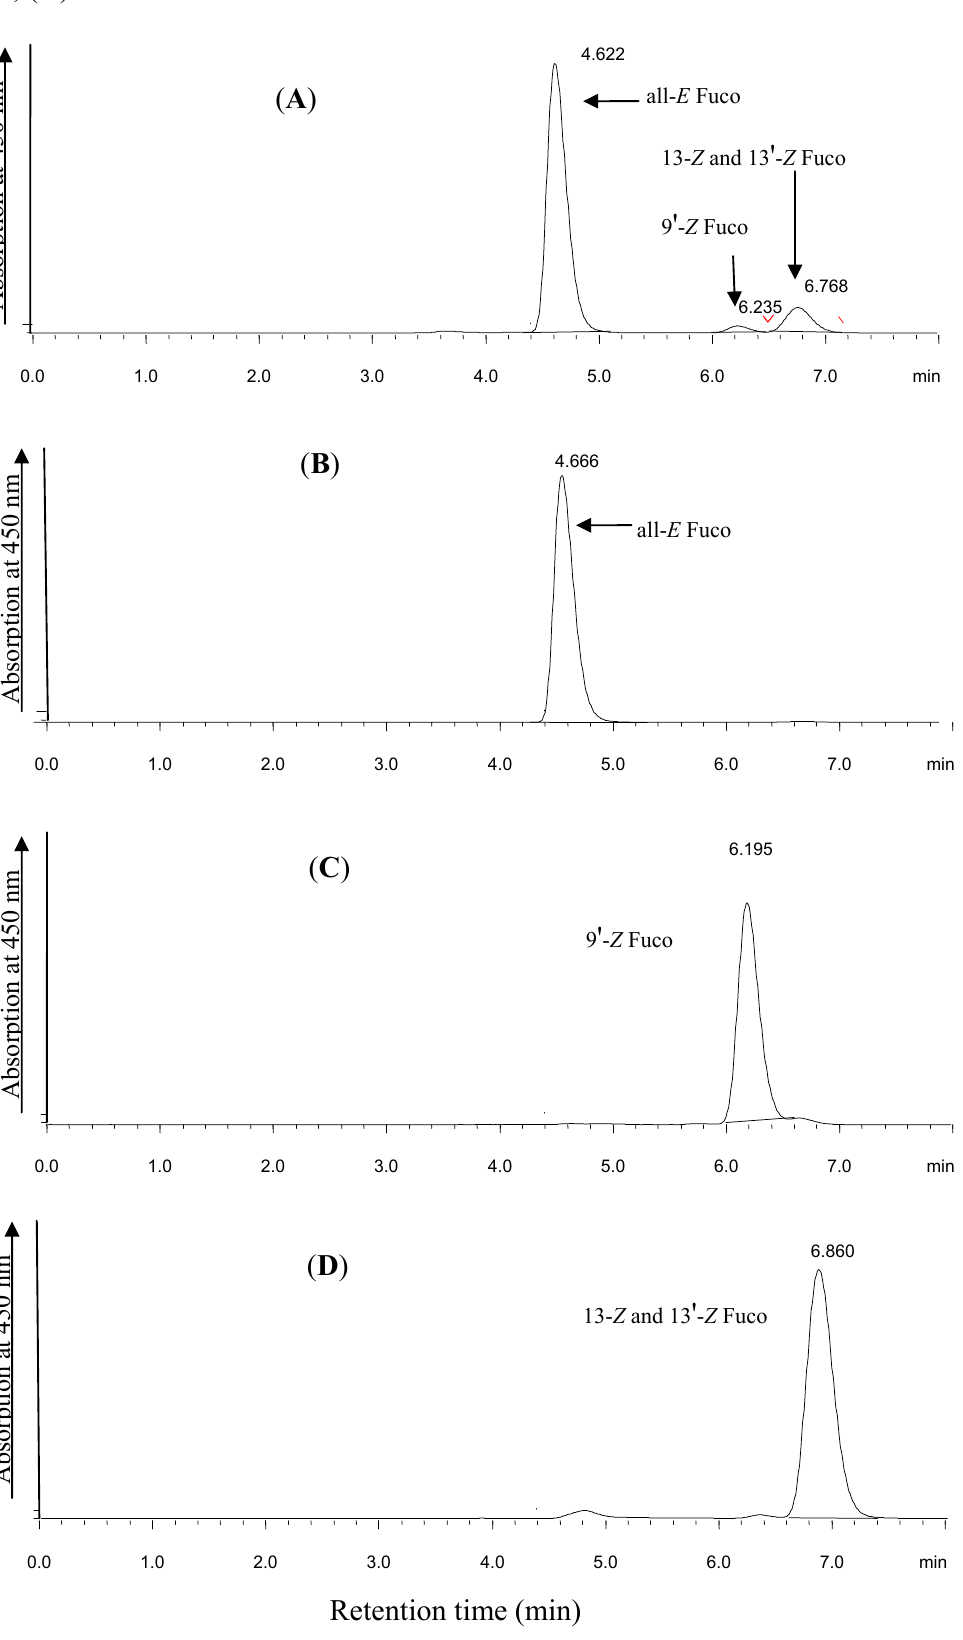
Figure 2. Chromatograms of Fuco and its isomers. ( A ) Crude product; ( B ) All- E Fuco; ( C ) 9' Z -Fuco; ( D ) 13 Z - and 13' Z